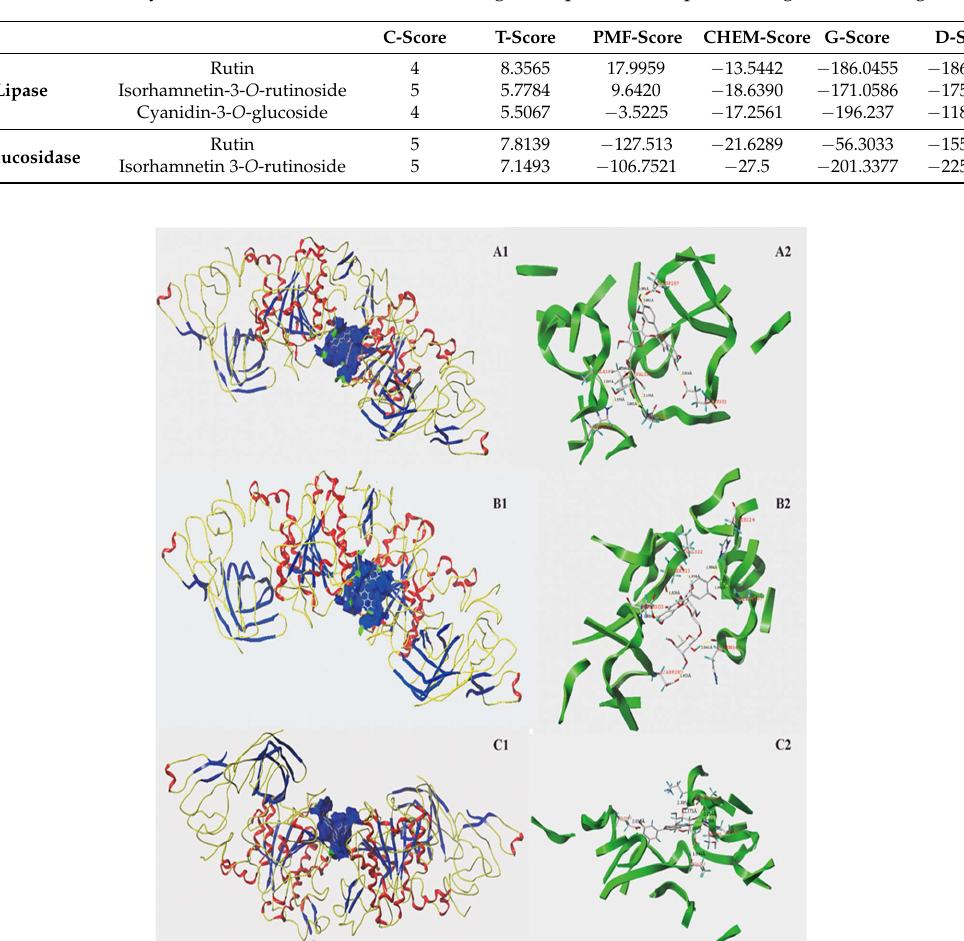
Table 3. The analysis results of the molecular dockings into pancreatic lipase or α -glucosidase ligands.